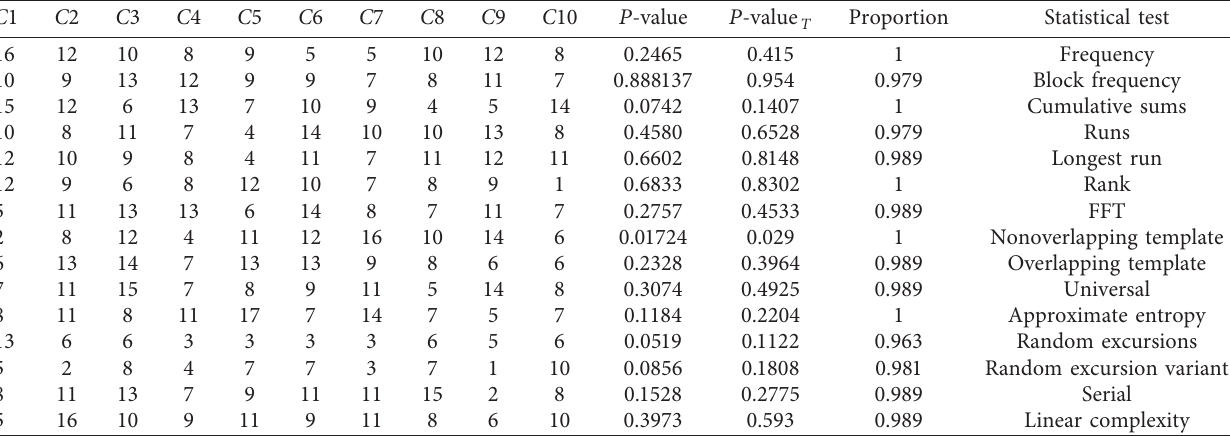
Table 3: NIST test result of Case 2